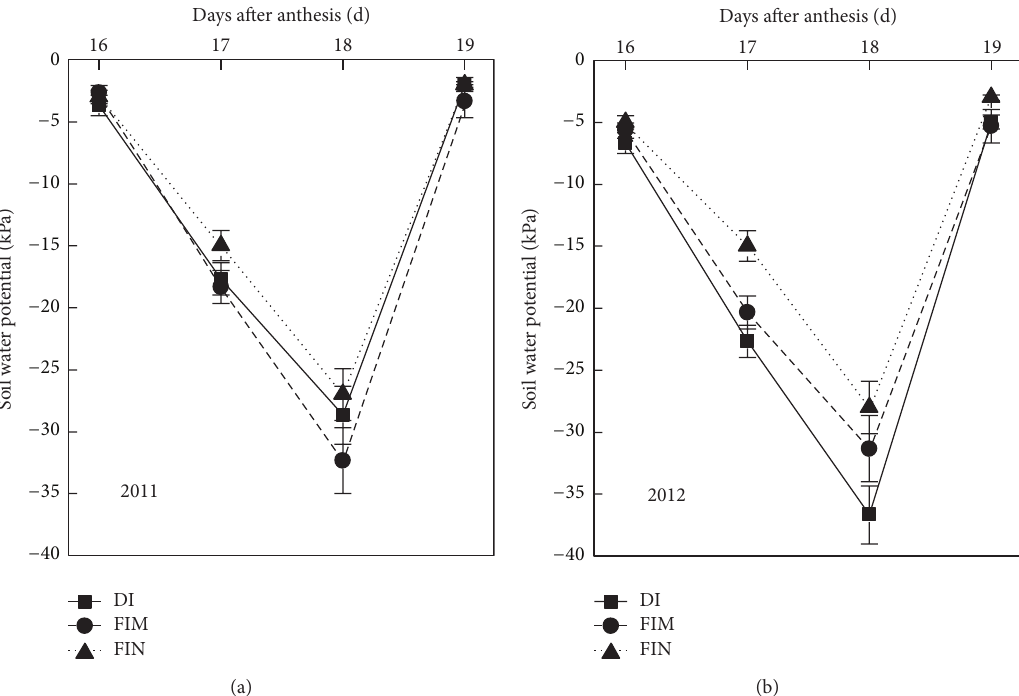
Figure 3: Soil water potential at 0–20 cm soil layer under nonflooded irrigation treatments from the 16th day after anthesis to the 19th day after anthesis in Shihezi in 2011 (a) and 2012 (b). Vertical bars represent SE of the mean; the SE was calculated across three replicates for each